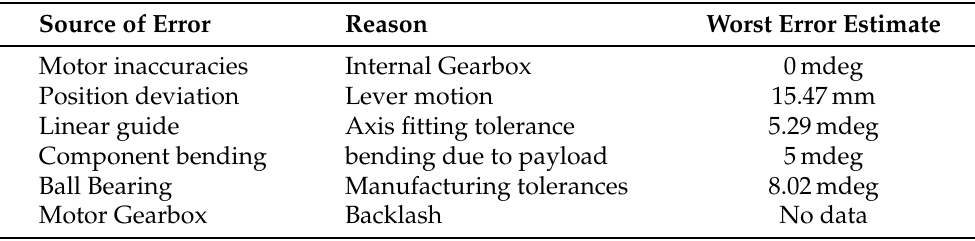
Table 3. From the utilized components and overall system design, several sources of error can be identified and accounted for in the further steps of the system’s design.